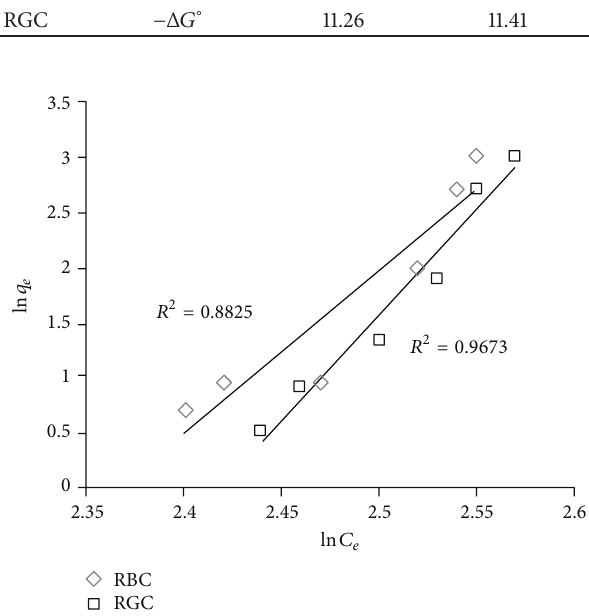
Figure 8: Logarithmic plot of Freundlich equilibrium isotherms of OM absorbed onto RBC and RGC.